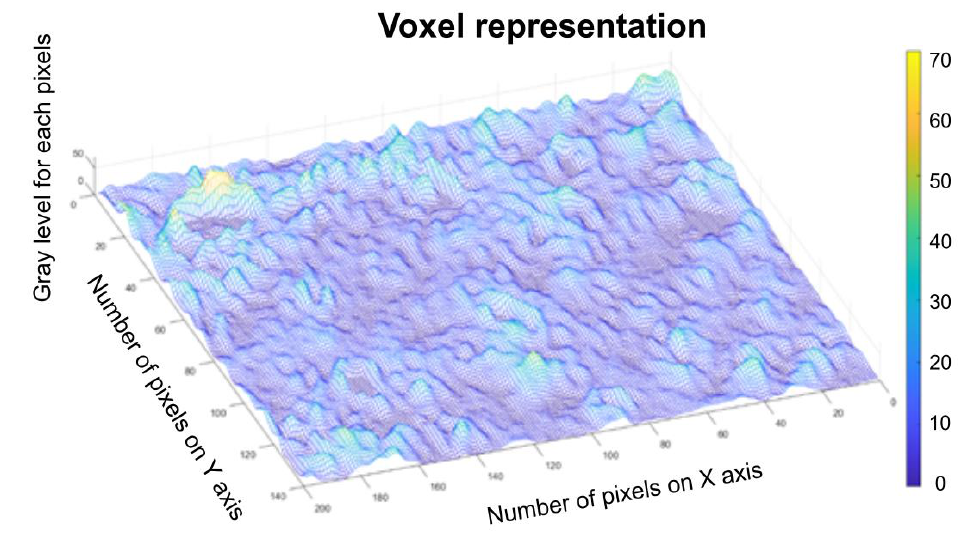
Figure 10. Voxel representation for the image U 1 .